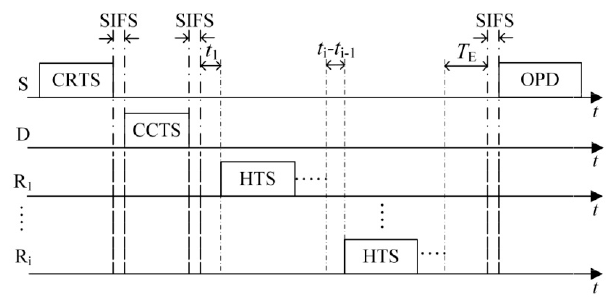
Figure 4. Second case of optimal cooperative node group: No cooperative nodes with higher cooperative gain contend within a time interval of T E .